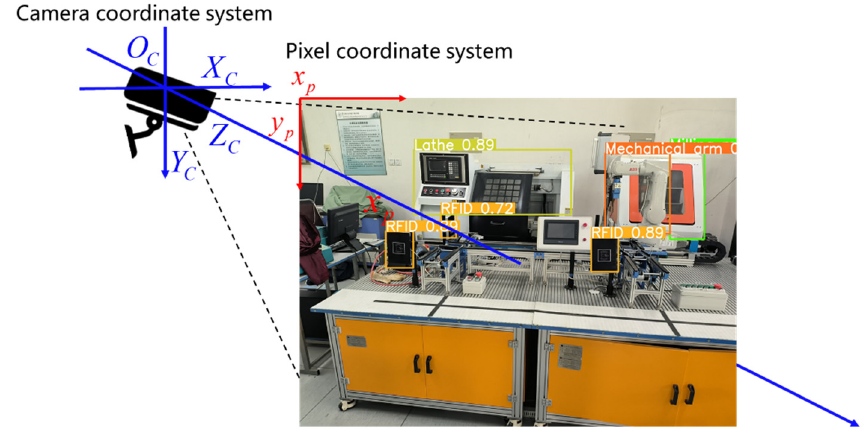
Figure 1. The pixel coordinate system and the camera coordinate